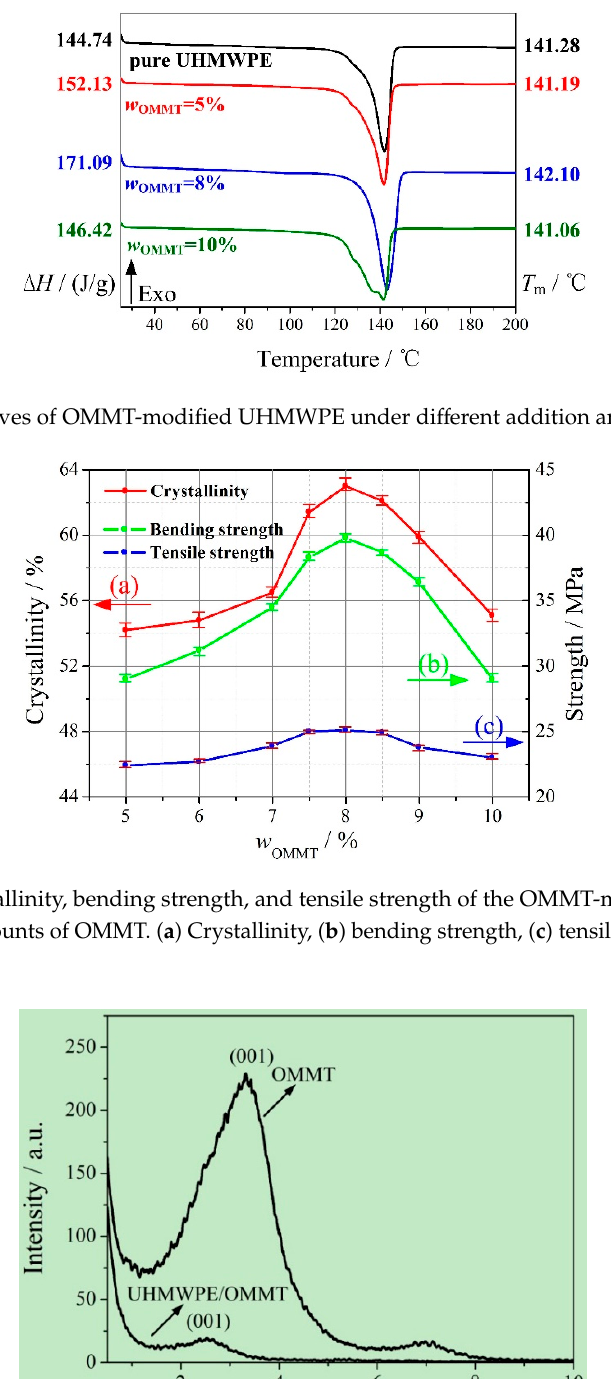
Table 4. Mass fraction of each component/%.